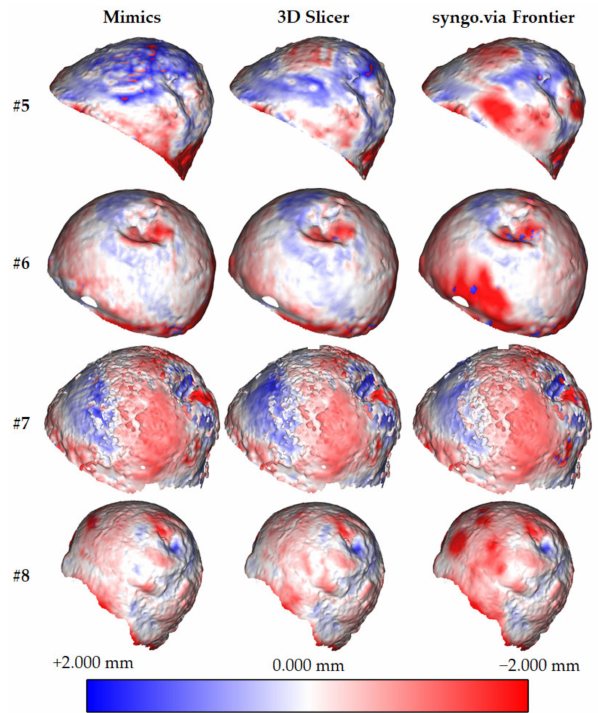
Figure 5. Signed Euclidean distance between the reference ( G_D ) and test ( G_A , G_B , and G_C ) geometries for patients #5, #6, #7, and #8. The deviation is represented in the reference geometry. Red: − 2.000 mm deviation. White: 0.000 mm deviation. Blue: +2.000 mm